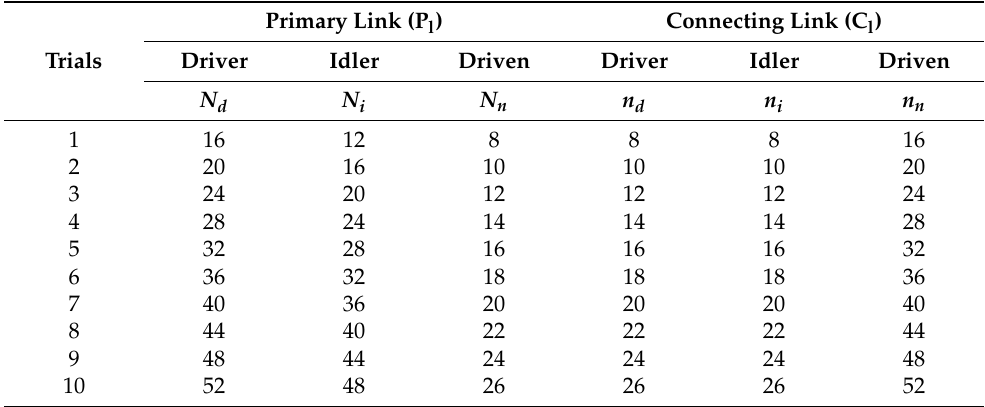
Table 5. Number of spur gear teeth combinations for primary and connecting links as indicated for the driver, idler, and driven gear for the indicated trial number.